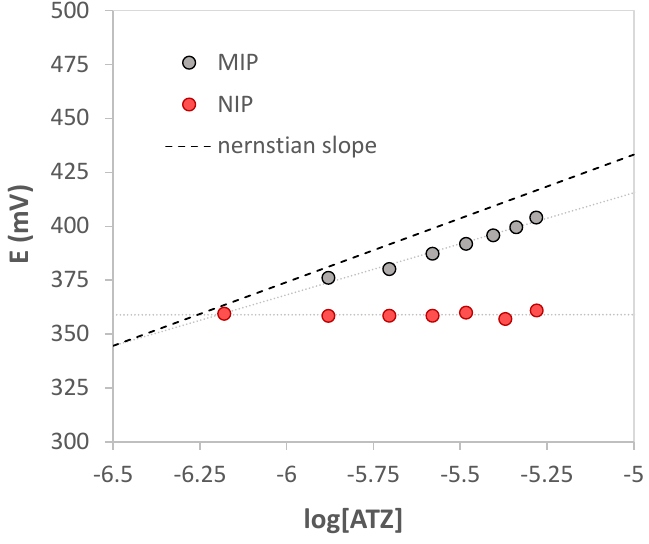
Figure 7. Nernst’s plot E vs. log [ATZ]. V = 15 mL of HCl pH = 1.5. grey bullets MIP, red bullets NIP. The dotted black line represents the theoretical Nernstian slope for monovalent cation.